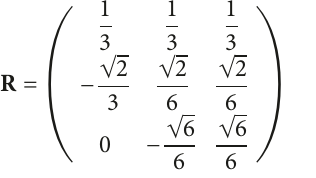
Figure 3: Two s-Enneper surfaces and interpolants satisfying 𝐻 1 𝐶 and four interpolants satisfying 𝐻 1 𝐶 on Σ 𝜆 1 ; (c) four interpolants satisfying